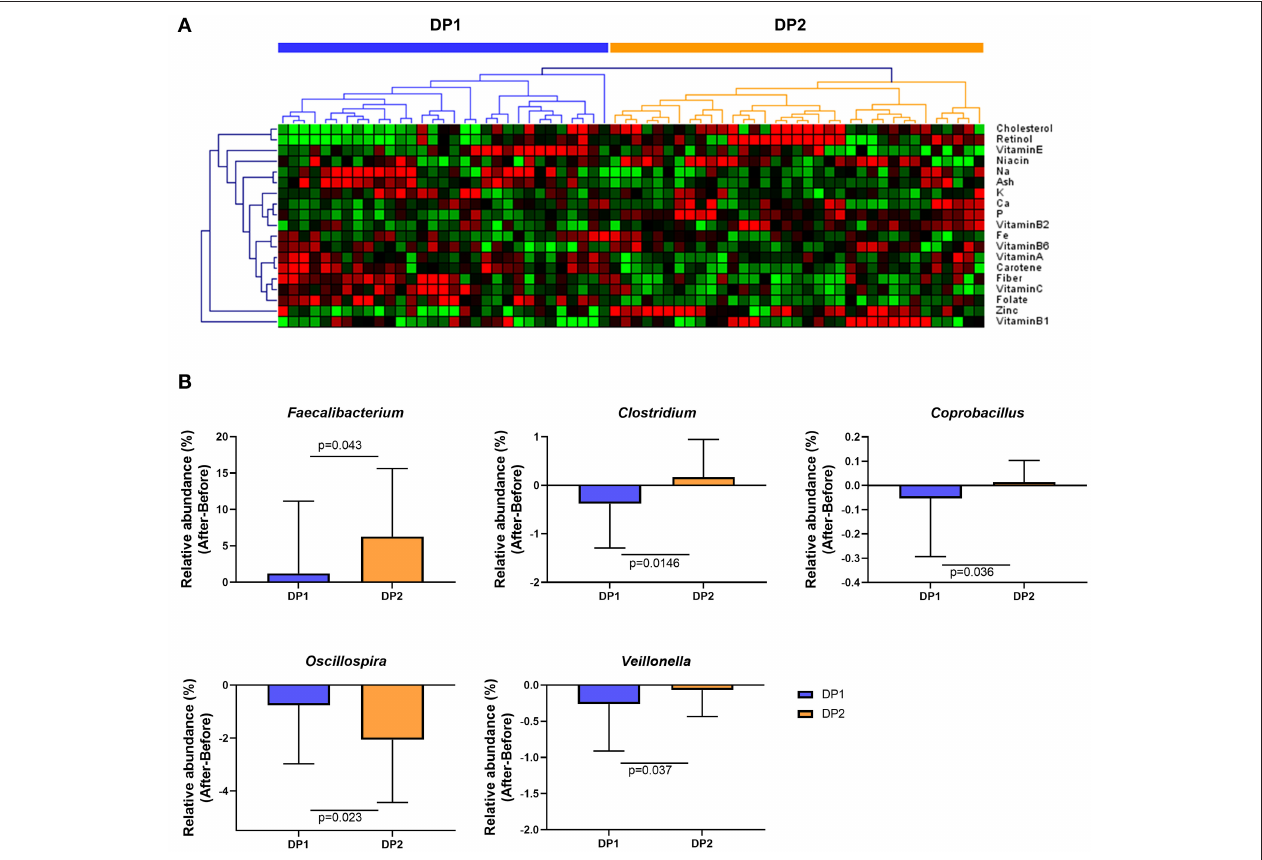
FIGURE 5 | Changes in gut microbial composition after Saengshik supplementation according to dietary-pattern clusters. (A) Hierarchical clustering heatmap of nutrient-consumption data. Results of unsupervised cluster analysis revealing two clusters based on nutrient intake of participants. Each column shows the nutrient-intake pattern of individuals in the DP1 ( n = 31) and DP2 ( n = 35) groups. The amount of each nutrient in individual samples is expressed as a relative value obtained by the auto-scaling method and represented by color, where red and green indicate high and low concentrations of nutrients, respectively. Values were measured by Euclidean distance with an average linkage clustering algorithm. (B) Changes in the relative abundance of significantly different gut bacterial genera between the DP1 (blue; n = 31) and DP2 (orange; n = 35) groups. The vertical axis shows the alternation of relative abundance, which is the delta value between the relative abundance (%) of samples before and after the intervention in each dietary pattern group (After minus Before in DP1 and DP2). P -values according to multiple t -tests were adjusted by the Benjamini–Hochberg false discovery rate (q < 0.05).